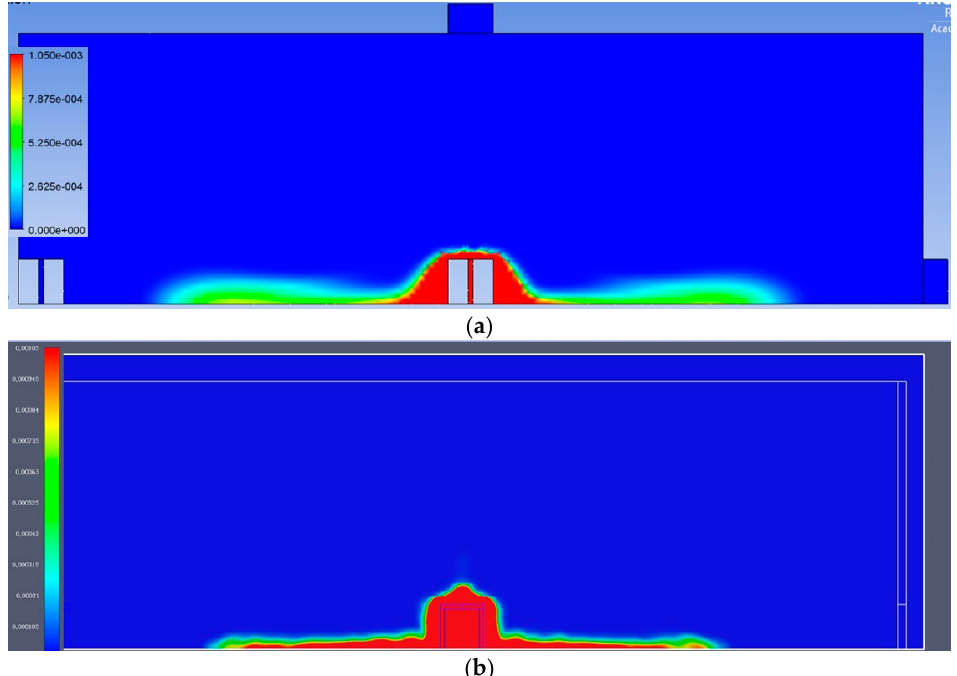
Figure 10. Comparison of propane dispersion for 5% concentration of LEL for time 100 s: ( a ) propane release calculated with Ansys software; ( b ) propane release calculated with FDS software.